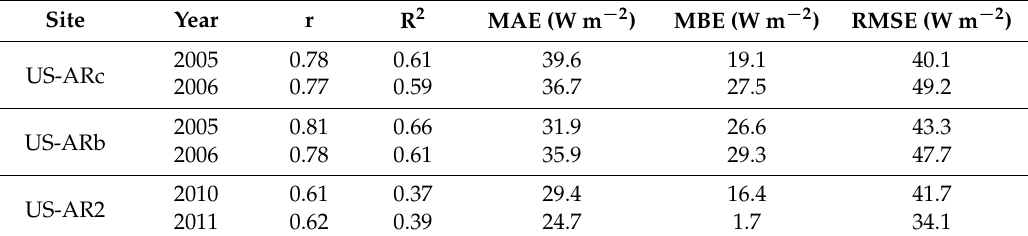
Figure 3. Comparison of daily ET from surface energy balances (SEBS) and flux tower (FT). Table 1. Statistical indicators between SEBS and flux tower ET.